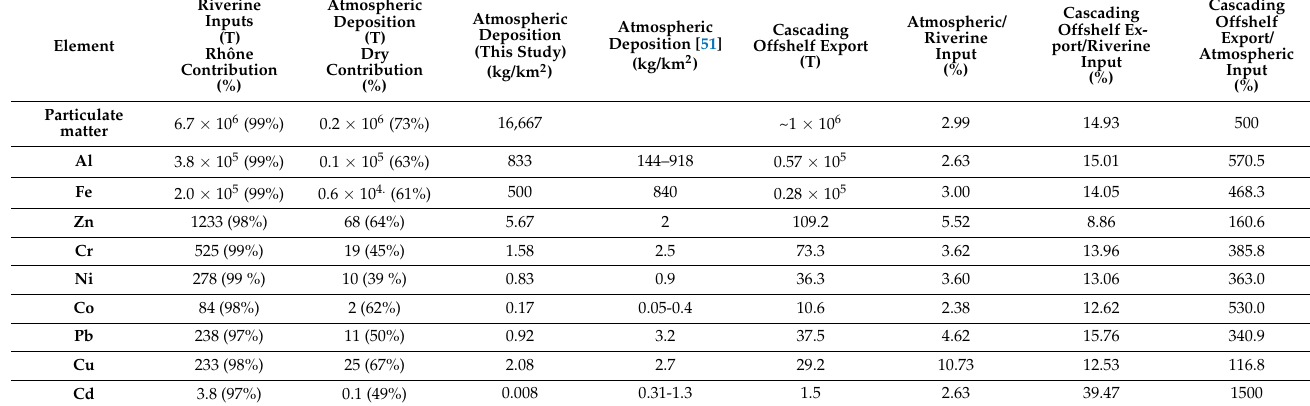
Table 1. Estimation of the riverine and atmospheric inputs of particulate matter and PMTs to the Gulf of Lions continental shelf for the entire year of 2012, and export from the shelf to the basin during winter 2012. The contribution of the Rh ô ne and dry deposition to the total riverine and atmospheric deposition, respectively, is shown.